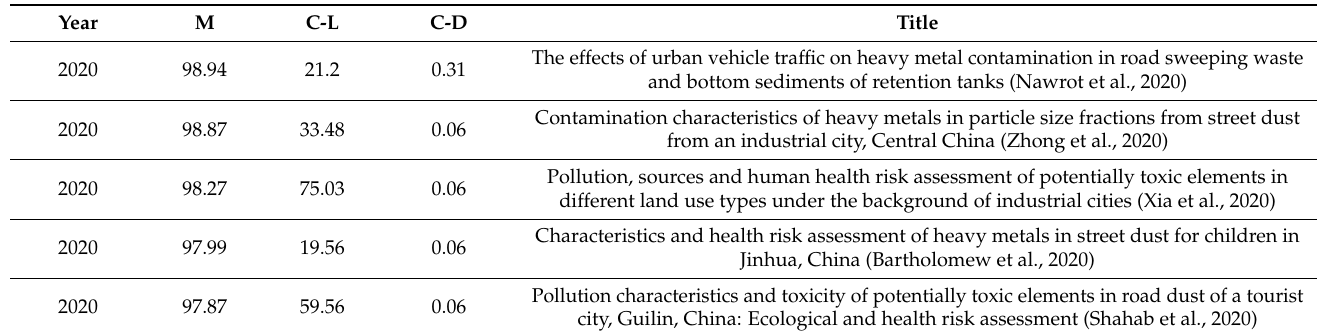
Table 9. Some of the articles with the strongest transformative potentials, M is ∆ Modularity, C-L is for ∆ Cluster Linkage, C-D is for ∆ Centrality